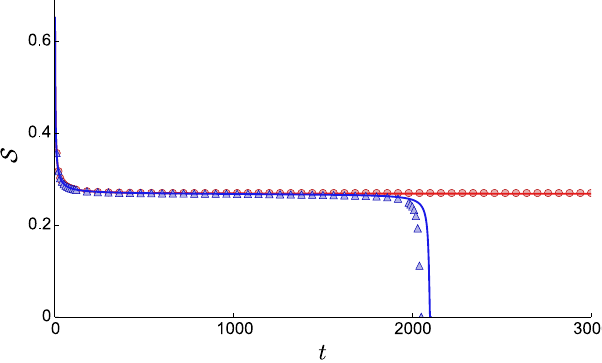
FIG. 2. Size S of the Erd ő s-Rényi network versus time t during the pruning process for k ¼ 3 in two cases. (i) Below the threshold h q i c , the system passes through a long “ plateau ” stage before a final collapse. Shown are numerical calculations for mean degree h q i ¼ 3 . 3509 (blue solid line) and simulations (triangles) for a network of 10 8 vertices showing similar total time. (ii) Above h q i c , the system relaxes to a finite size, numerical solution for h q i ¼ 3 . 350 92 (red solid line) and simulations (circles).